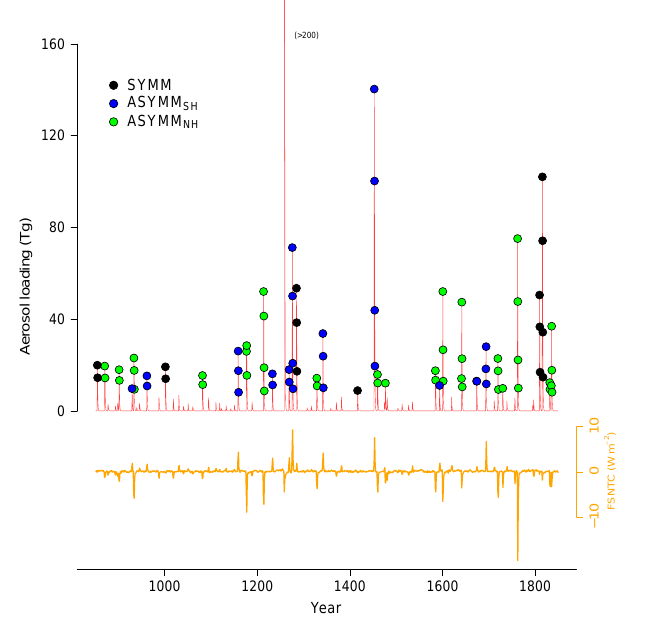
Figure 1. Global aerosol loading (Tg) from Gao et al. (2008) as red line. ASYMM NH (green circles), ASYMM SH (blue circles), and SYMM (black circles) events that are used in composites are shown. Note that Samalas is omitted, as discussed in text. The time series is at seasonal (5-month) resolution, and thus multiple points may be associated with a single eruption. The hemispheric contrast (NH minus SH) clear-sky net solar radiation (FSNTC – in Wm − 2 ) in CESM LME is shown in orange (offset to have zero